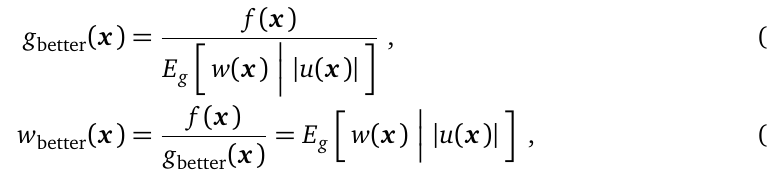
Figure 7: The percent increase (indicated by the horizontal arrows in Figure 6) in the required amount of simulated data to reach the same value of regular IS instead of OASIS, as a function of N / L value a particular OASIS distribution was trained to be optimal N s